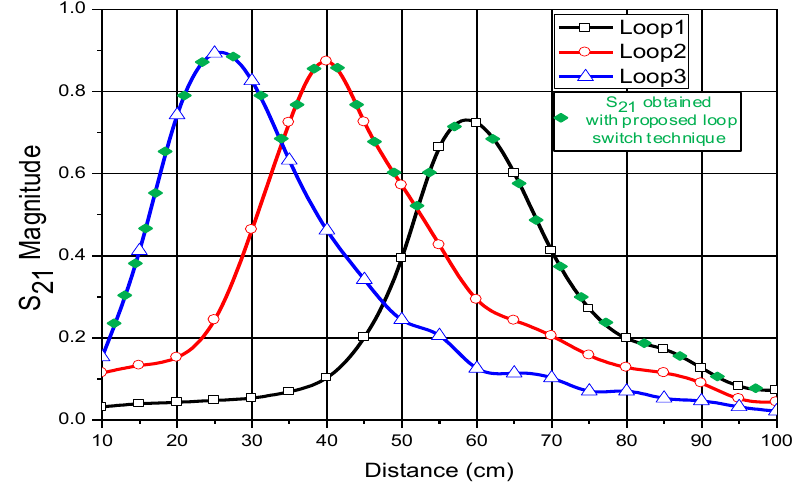
Figure 11. Measured S 21 magnitude using VNA for different loops with varying d 23 in the Case 2 system.